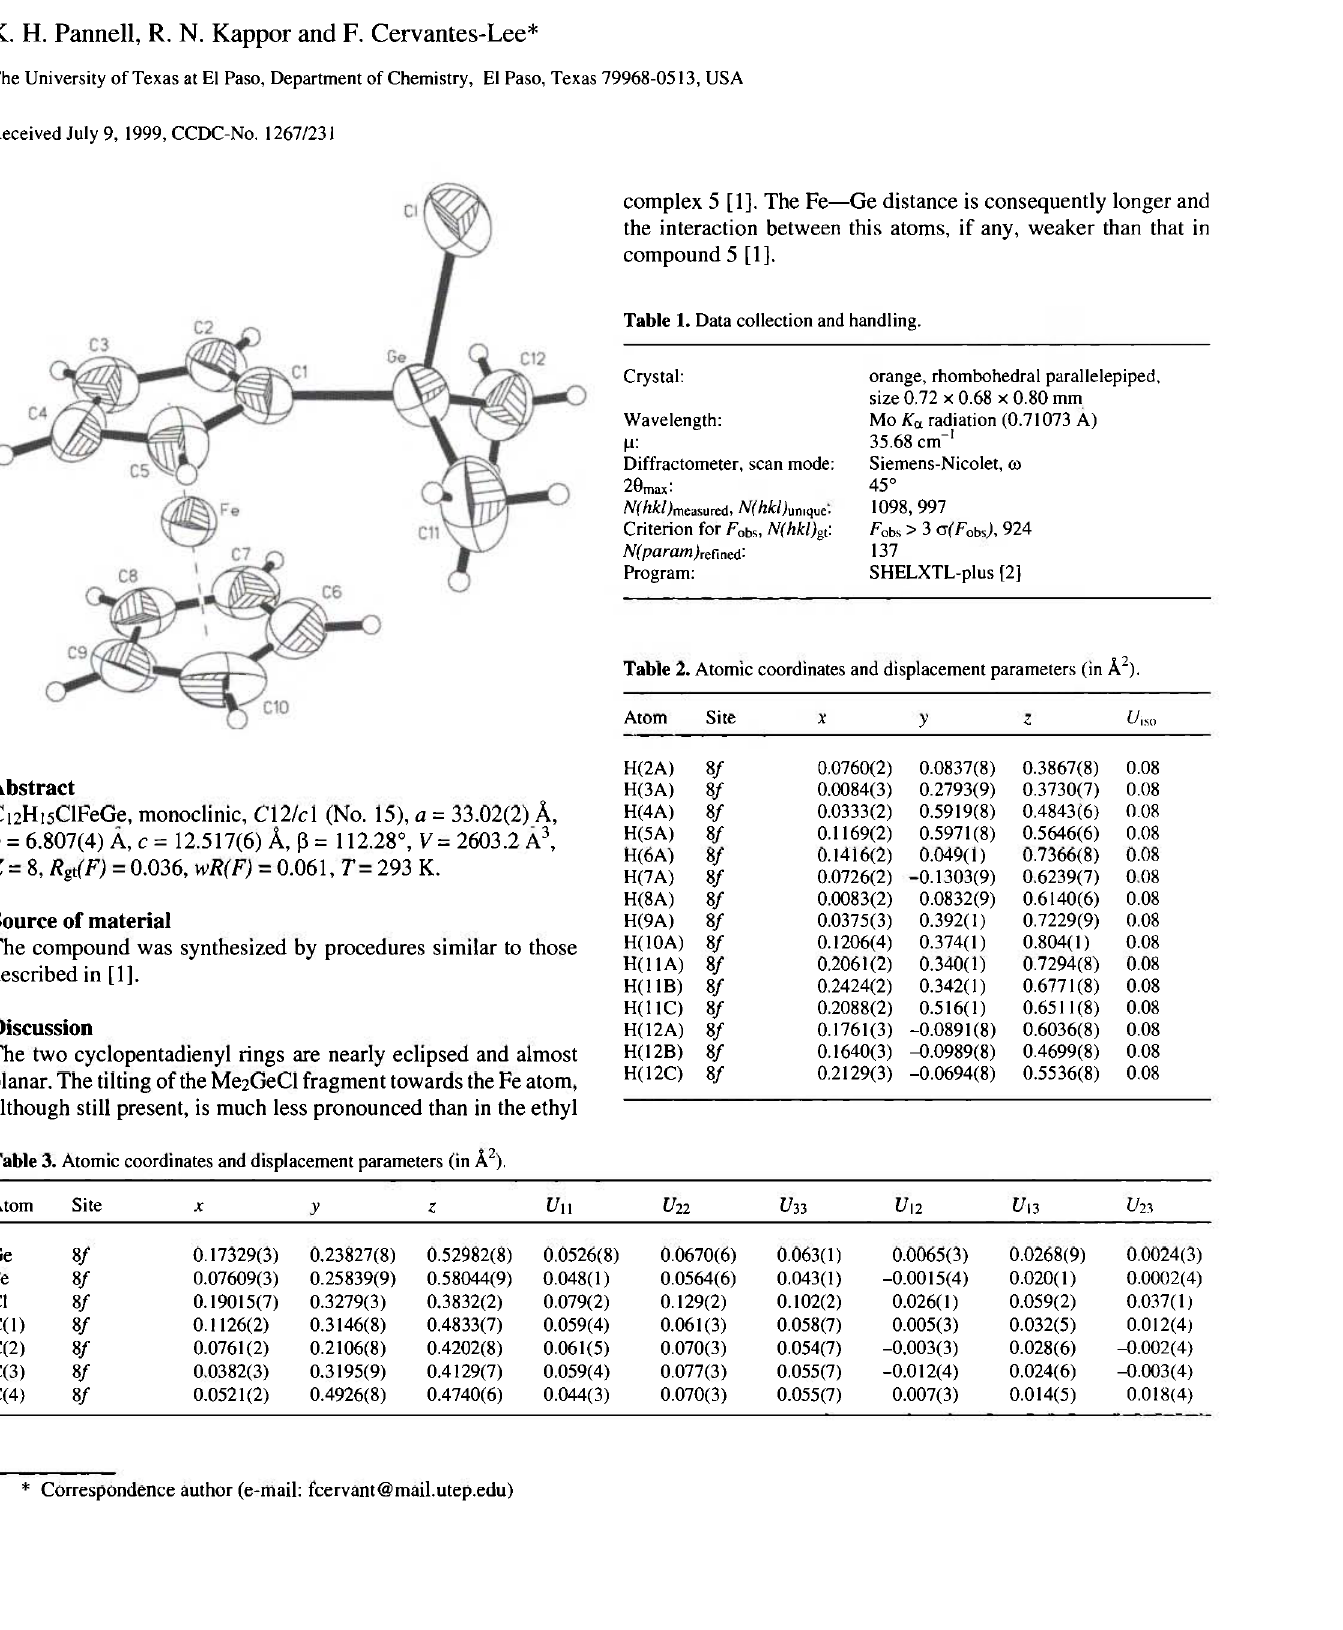
Table 1. Data collection and handling.